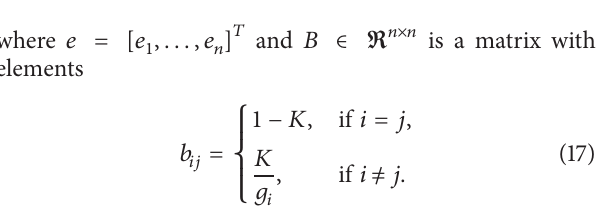
Figure 1: Example of Formation